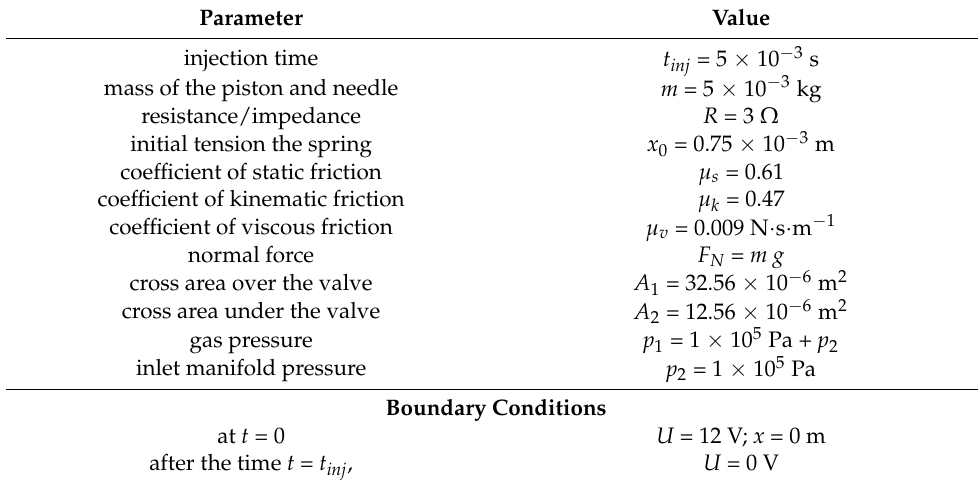
Table 2. The parameters and function conditions needed to initiate the simulation.